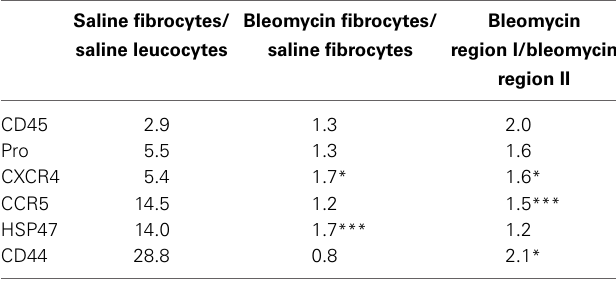
Table 2 | Phenotypic differences among fibrocytes and between fibrocytes and